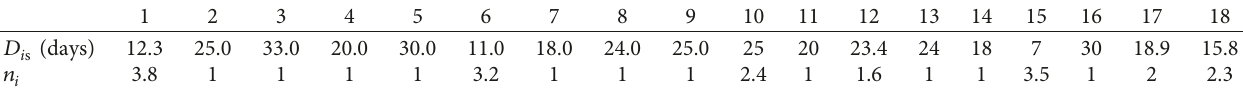
Table 3: The optimized duration and resource of each activity with the combinatory method.